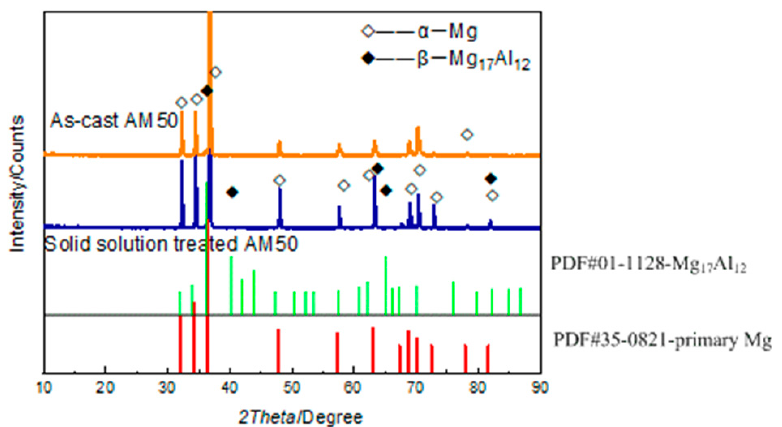
structure signi fi cantly decreased, and only a small amount was left in the grain boundary.